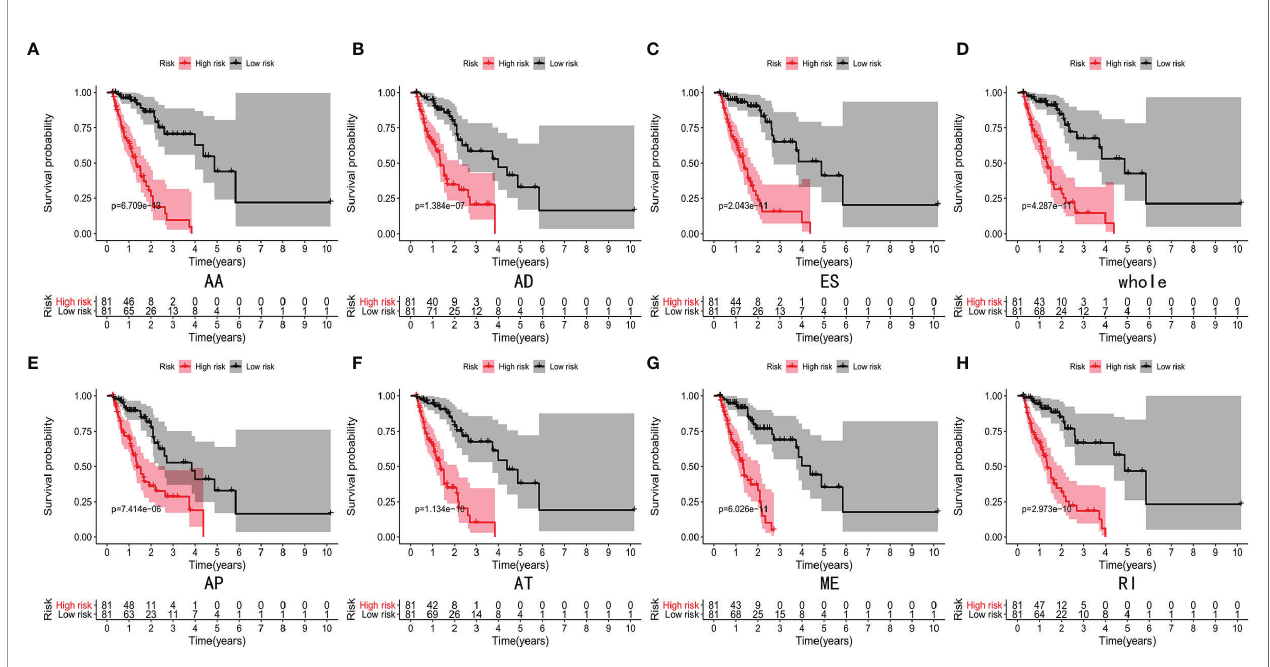
FIGURE 4 | K-M curves analyses showed signi fi cant differences of AA type (A) , AD type (B) , ES type (C) , whole type (D) , AP type (E) , AT type (F) , ME type (G) and RI type (H) in survival time between the low-risk (81 cases) and high-risk (81 cases) groups of EC